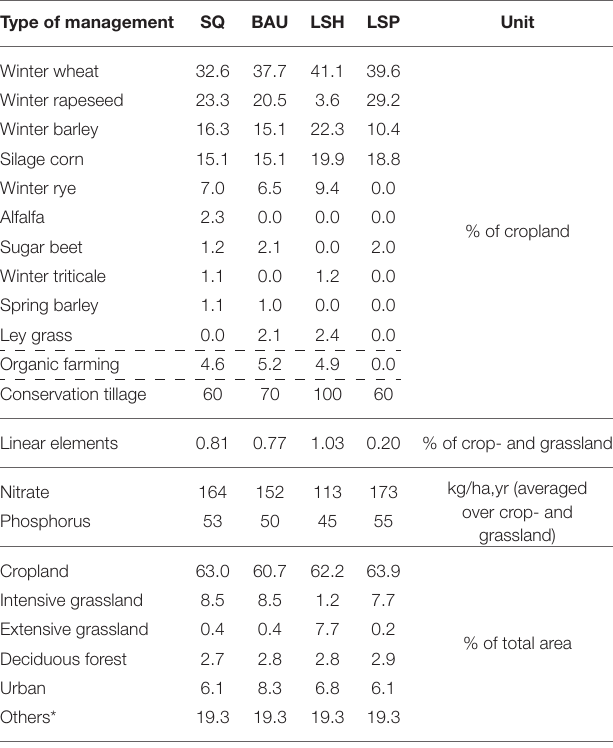
TABLE 1 | Land management of the Lossa River Basin under different